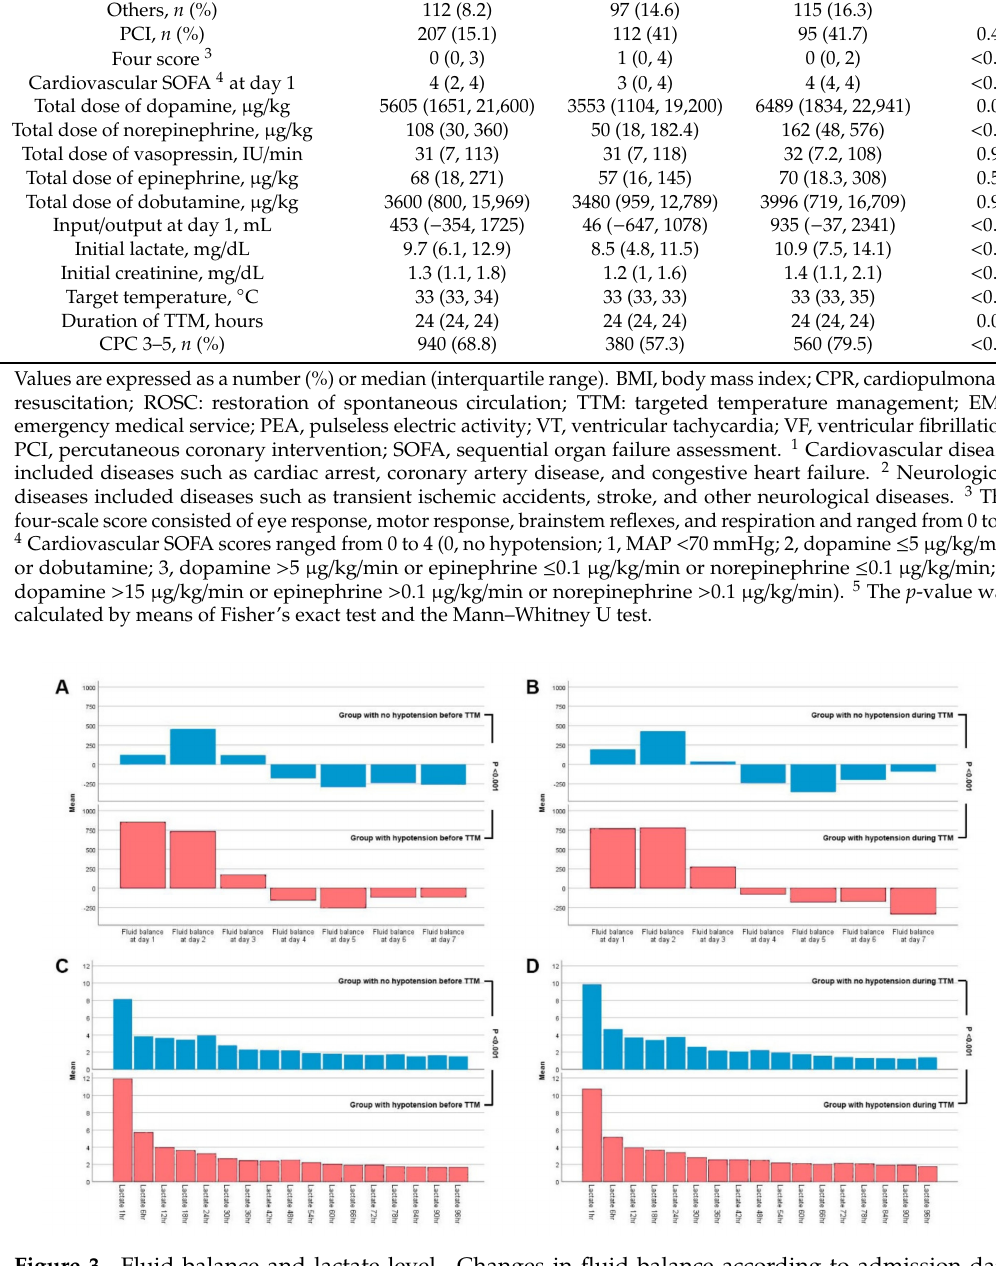
Figure 3. Fluid balance and lactate level. Changes in fluid balance according to admission date compared between the no-hypotension group and the hypotension group before TTM initiation ( A ) and during the TTM period ( B ). Changes in lactate level over time compared between the no-hypotension group and the hypotension group before TTM initiation ( C ) and during the TTM period ( D ). The lactate level and fluid balance after 2 days showed statistically significant di ff erences between the two